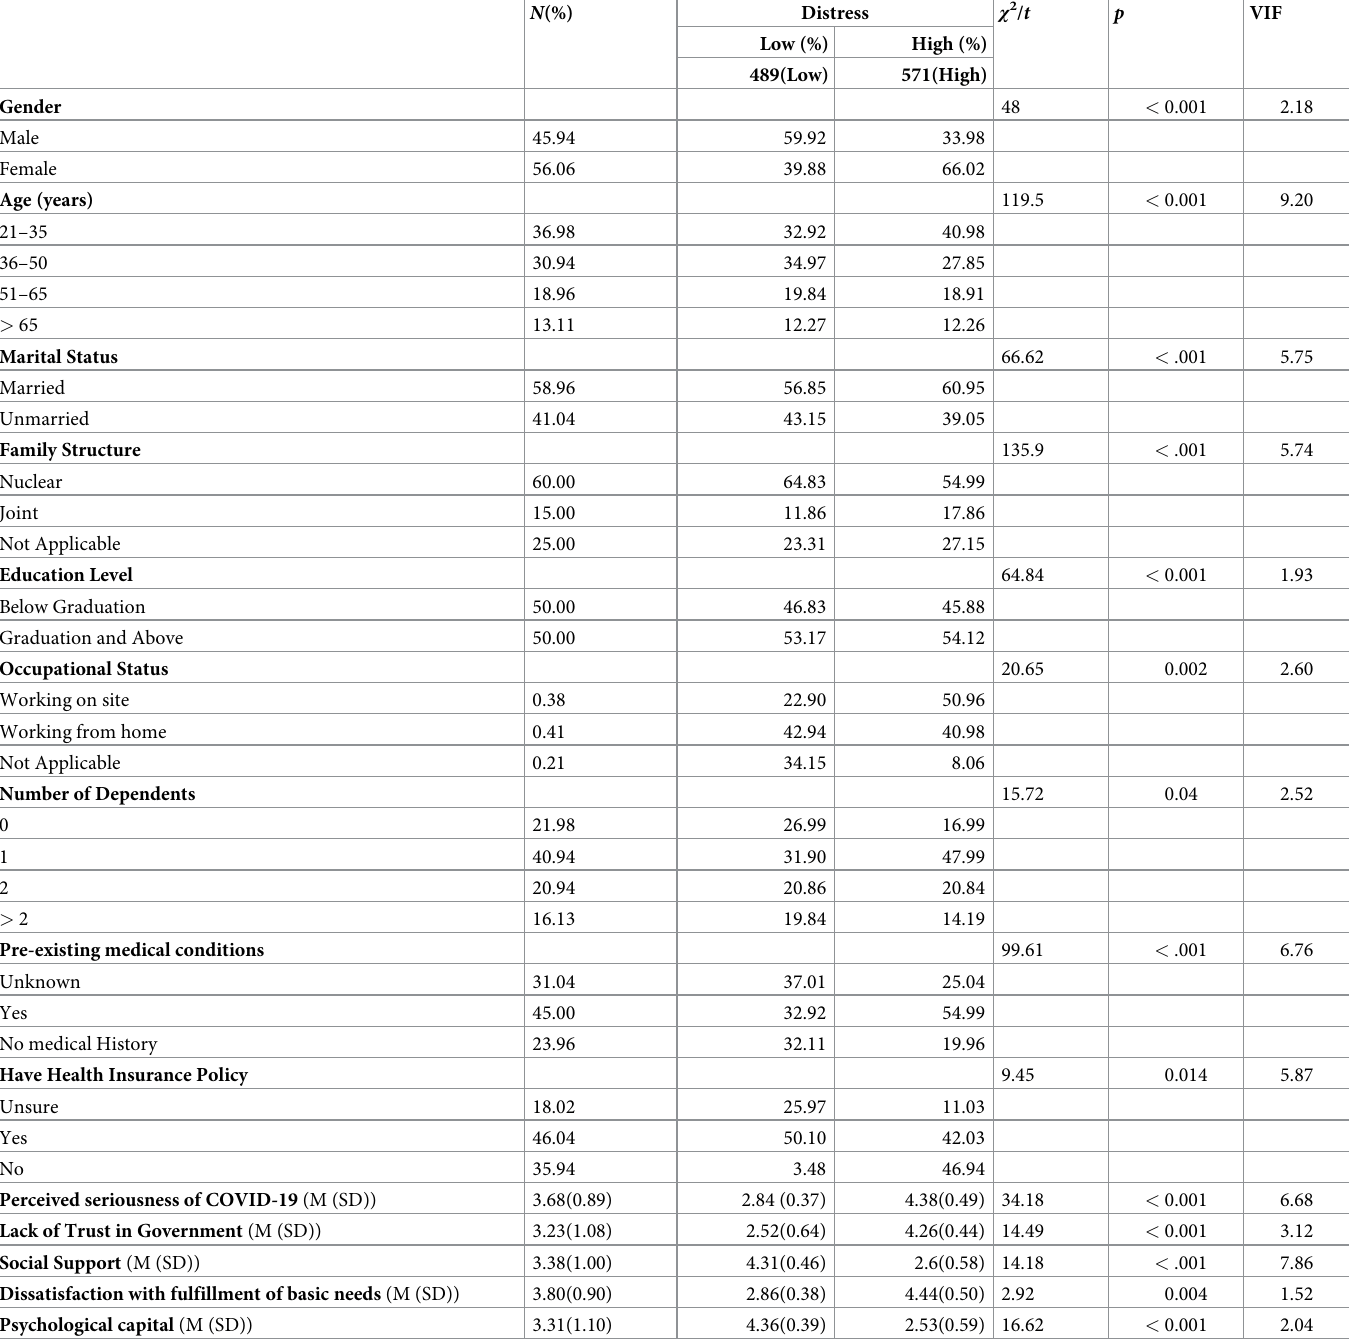
Table 1. Association between variables and distress during the COVID pandemic ( N =